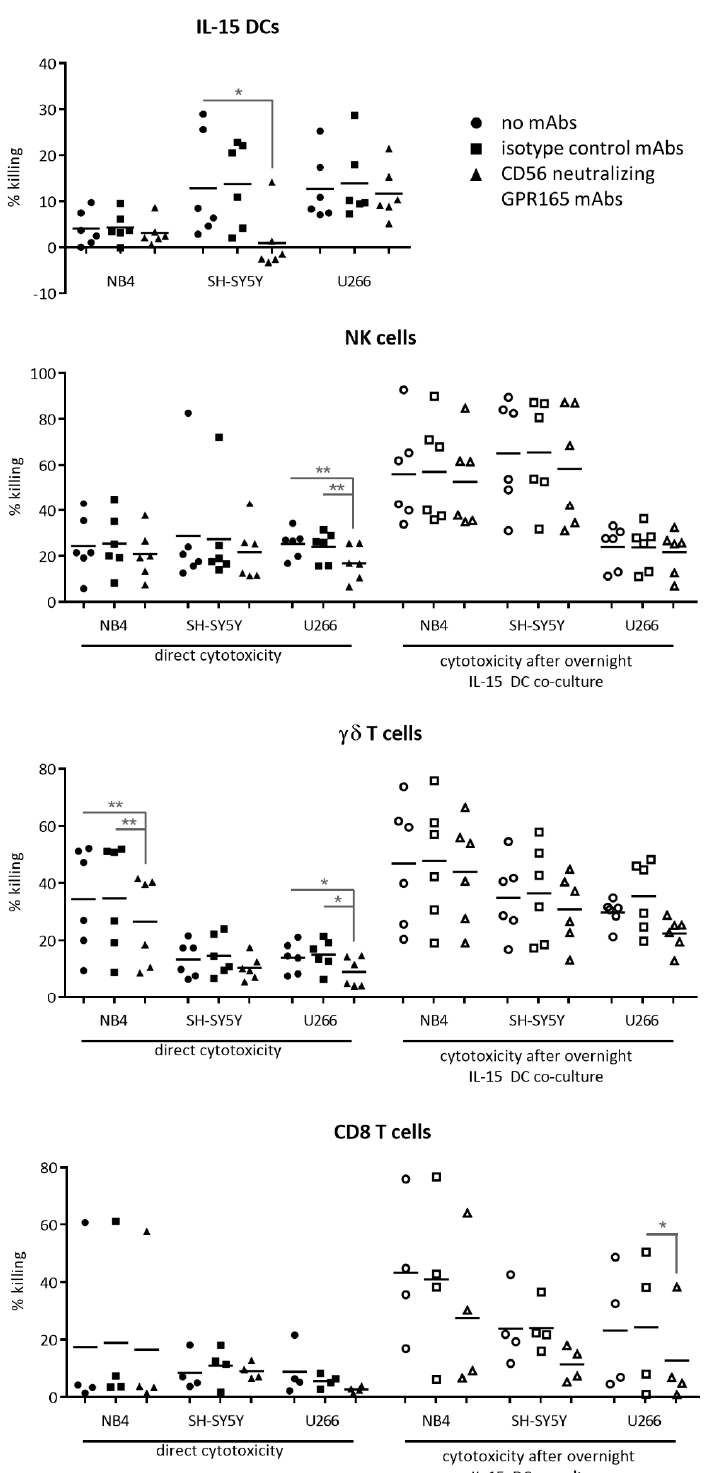
Figure 3. Involvement of Cluster of differentiation (CD)56 in immune effector cell activation and tumor cell killing. Immune cell cytotoxicity was defined against the cell lines NB4, SH-SY5Y, and U266, unstimulated and after overnight culture with interleukin (IL)-15 dendritic cells (DCs). Immune cells were cultured in medium without neutralizing monoclonal antibodies (mAbs) (circles) or in medium containing either CD56 neutralizing GPR165 mAbs (triangles) or its corresponding isotype control (squares) ( n = 4–6, two independent experiments). One-way ANOVA with Bonferroni’s multiple comparison test or Friedman test with Dunn’s multiple comparison test. ** p < 0.01; * p <